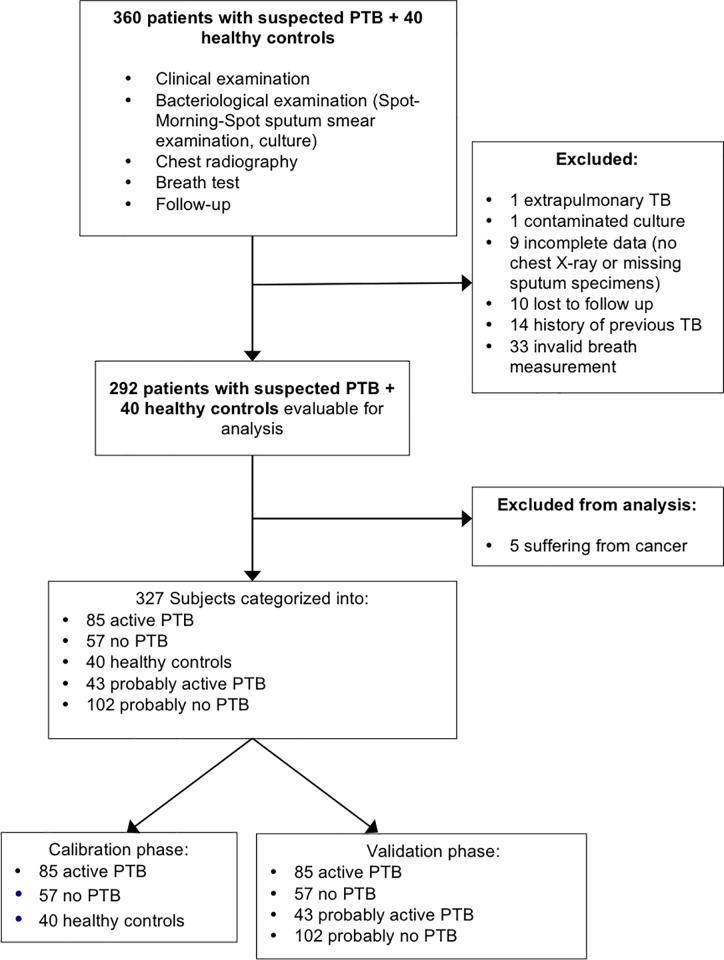
Flow-chart of study participants.